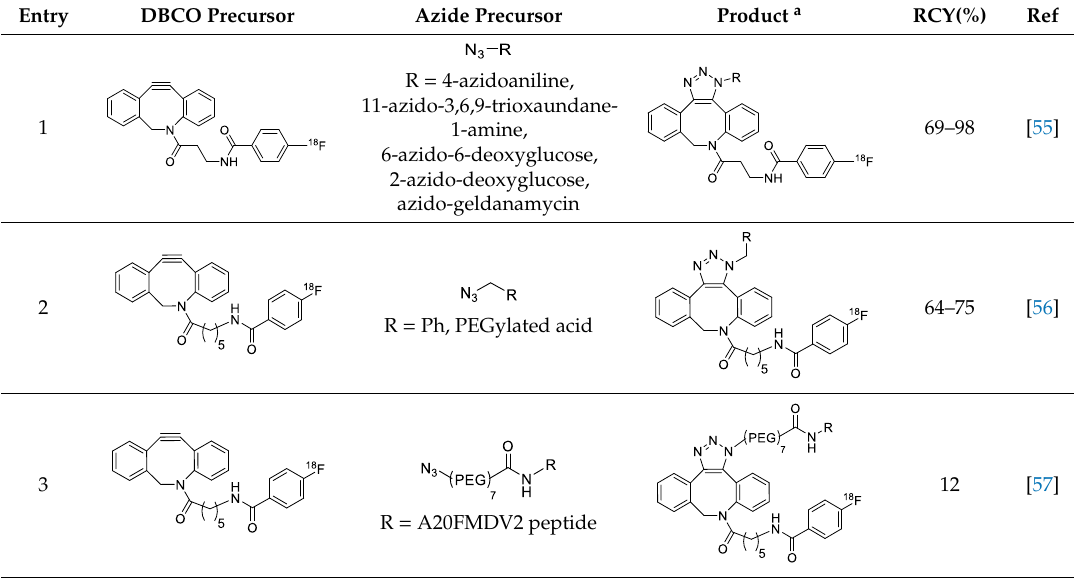
Table 1. Examples of SPAAC in labeling reactions using short half-life radioisotopes.